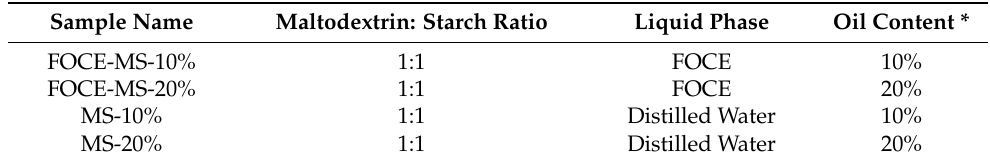
Table 1. Composition of the model